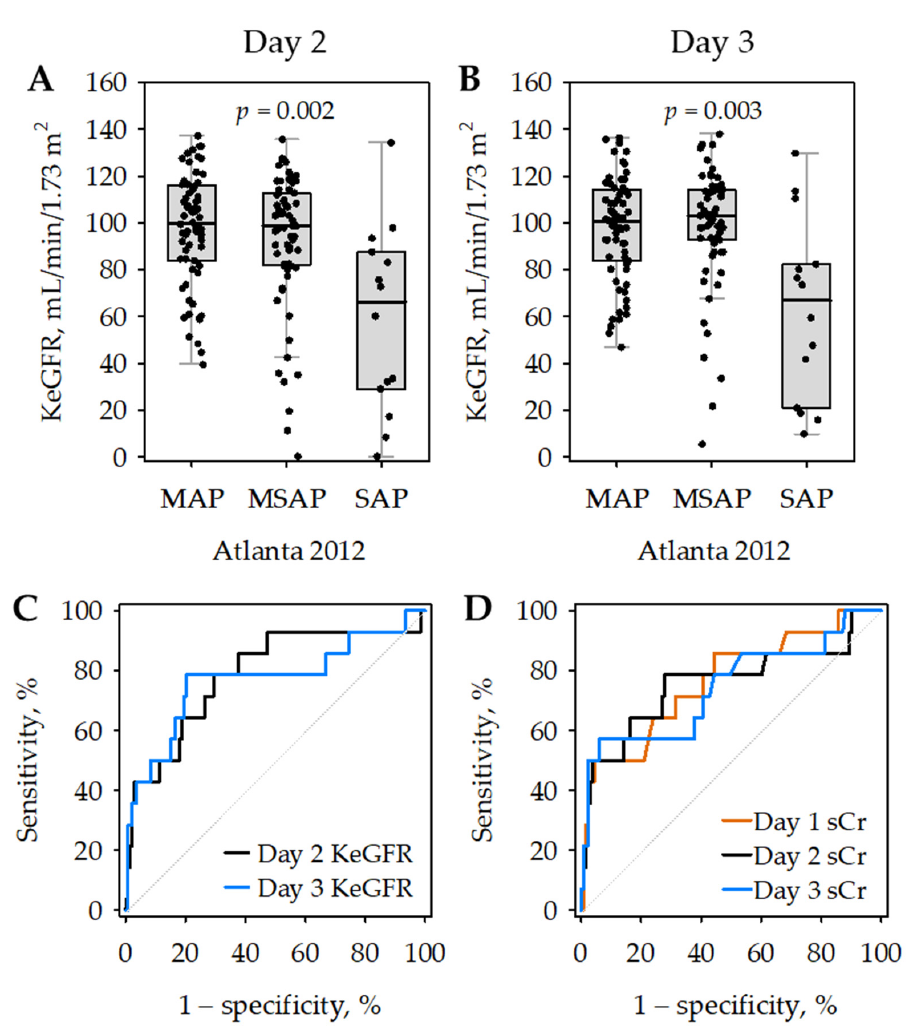
Figure 4. Kinetic estimated glomerular filtration rate (KeGFR) values on day 2 ( A ) and day 3 ( B ) of hospital stay according to the severity of acute pancreatitis (AP); p -values were calculated in Kruskal–Wallis test; patients with severe AP (SAP) differed significantly from those with mild AP (MAP) and moderately severe AP (MSAP) in post hoc tests. Data are shown as median (central line), interquartile range (box), non-outlier range (whiskers) and raw data (points). Receiver operating characteristic (ROC) curves showing the diagnostic accuracy of day 2 (black) and day 3 (blue) KeGFR for SAP ( C ). For comparison, ROC curves for serum creatinine (sCr) as a predictor of SAP are presented on panel ( D ) (day 1—orange; day 2—black; day 3—blue).